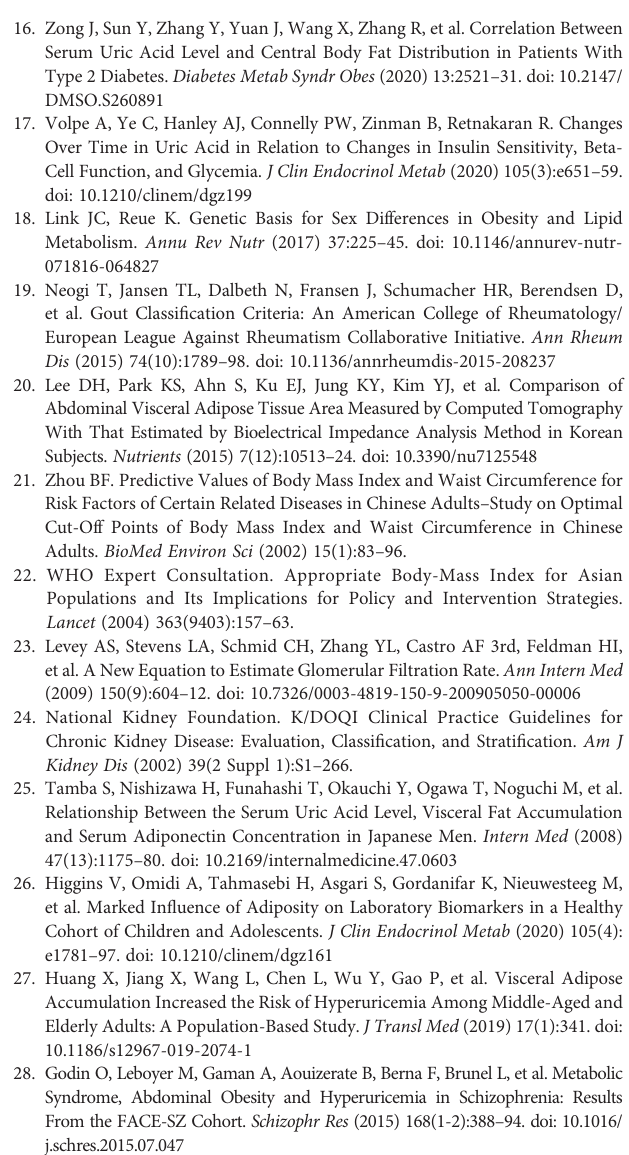
Supplementary Figure 1 | Comparisons of serum urate, weight, body mass index after urate-lowering treatment. Serum urate levels are shown as Mean ± SD, body weight and body mass index are shown as Median (IQR 25th-75th). P values are calculated by paired-sample t-tests or Wilcoxon Rank tests as